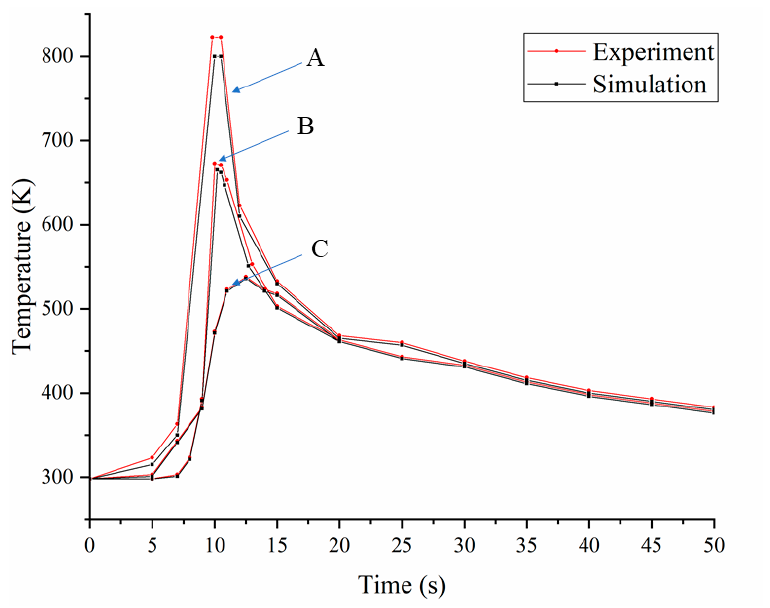
Figure 4. Temperature–time curve comparison of simulated and experimental results.